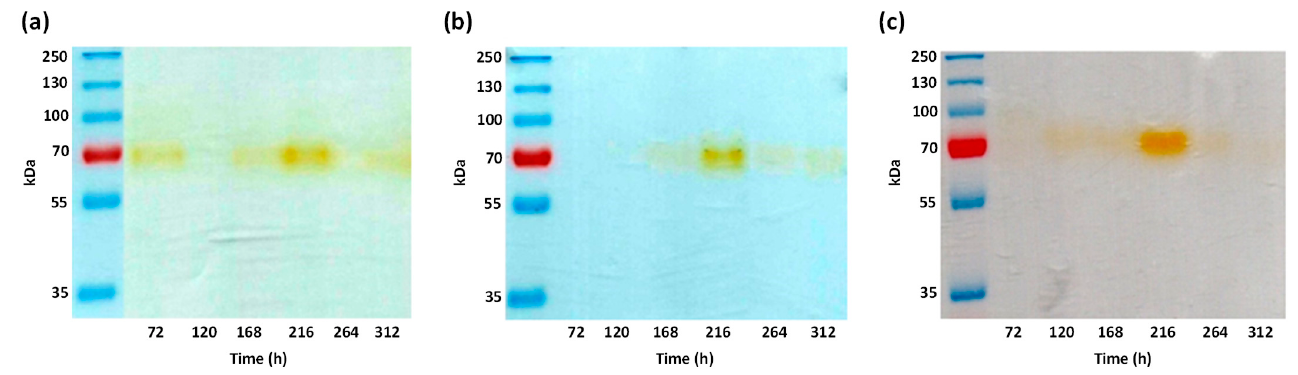
Figure 2. Detection of laccase activity by zymography assays from enzymatic extracellular crude extract (EECE). ( a ) Control (BM); ( b ) BM+CuSO 4 ; and ( c ) BM+HCB. 2,6-Dimethoxyphenol (2,6-DMP) was used as a substrate at a concentration of 2 mM and 7 μ g of total protein was loaded into each lane. Brown band indicates positive reaction to laccase.